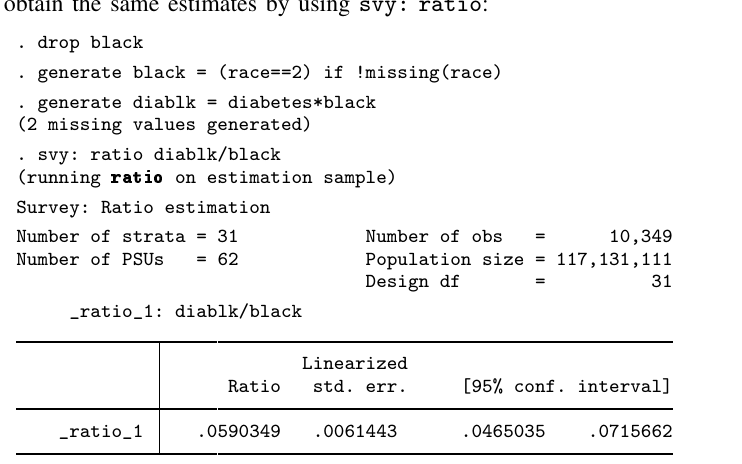
160 svy: tabulate twoway — Two-way tables for survey data Technical